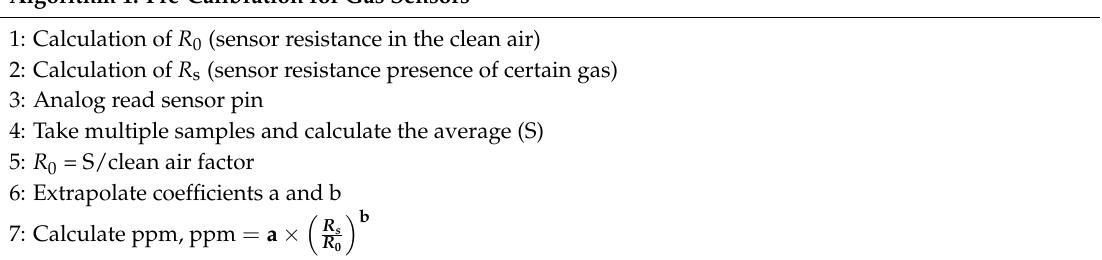
Algorithm 1: Pre-Calibration for Gas Sensors